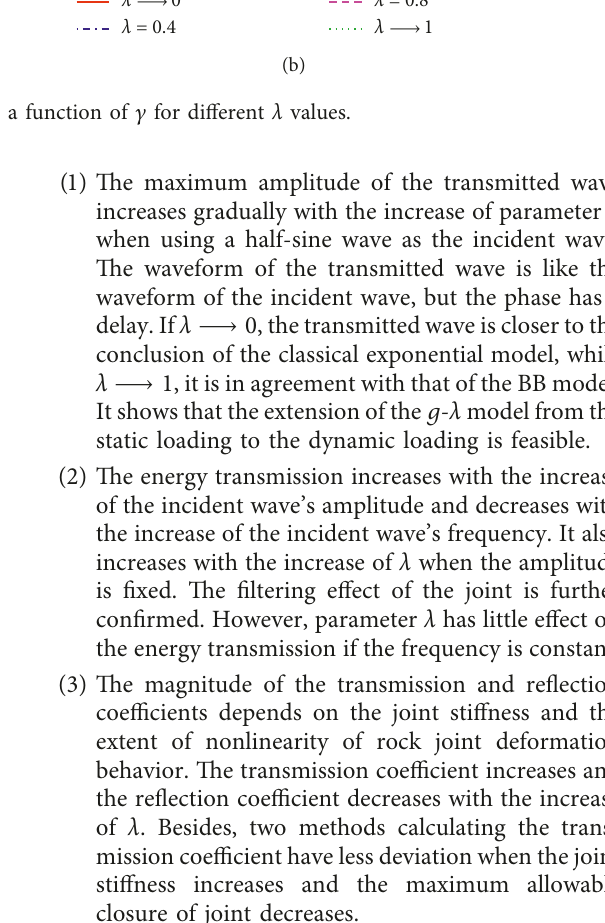
Figure 9: Transmission coefficient as a function of c according to two